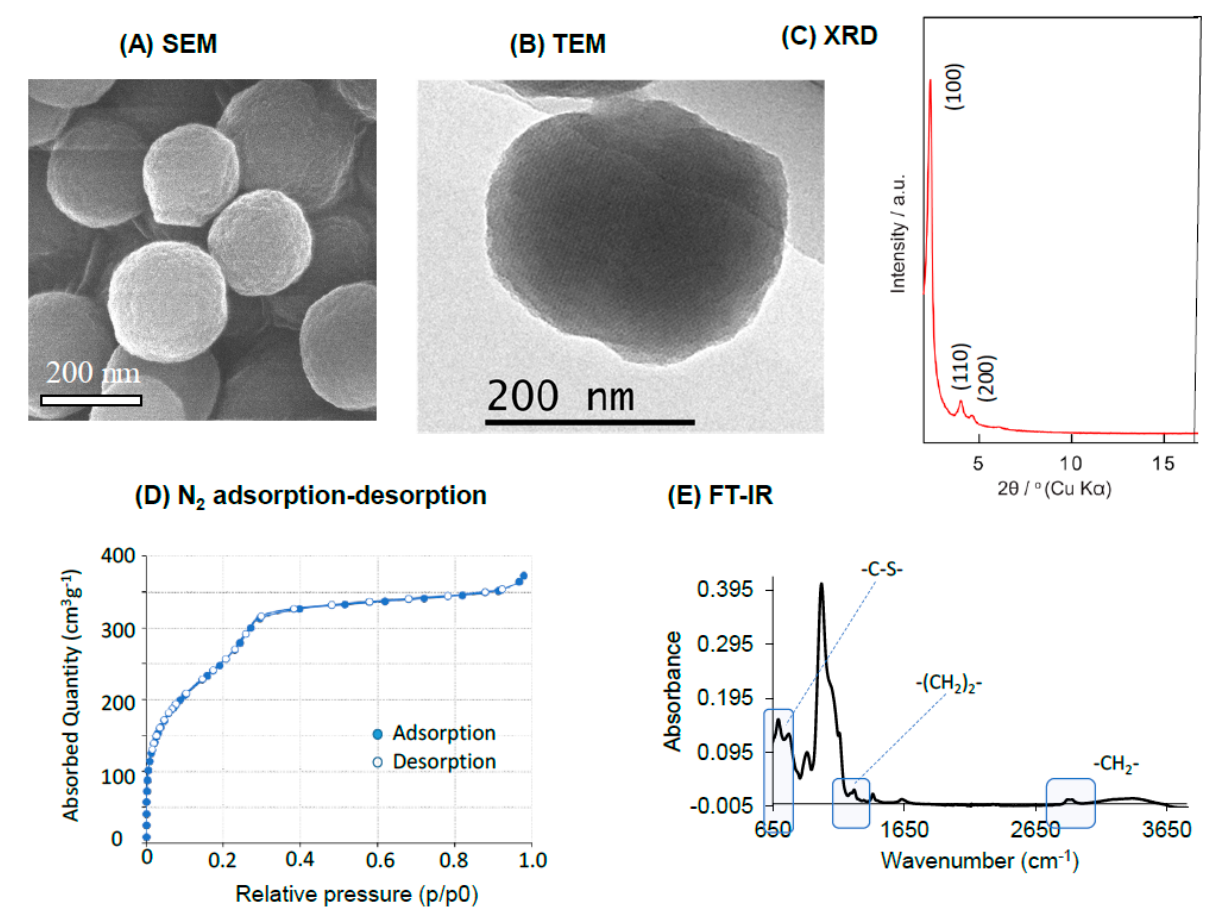
Figure 1. Characterization of biodegradable periodic mesoporous (BPMO) particles. ( A , B ) SEM and TEM pictures; ( C ) XRD analysis. ( D ) Nitrogen adsorption–desorption analysis; ( E ) FT-IR anal- ysis .